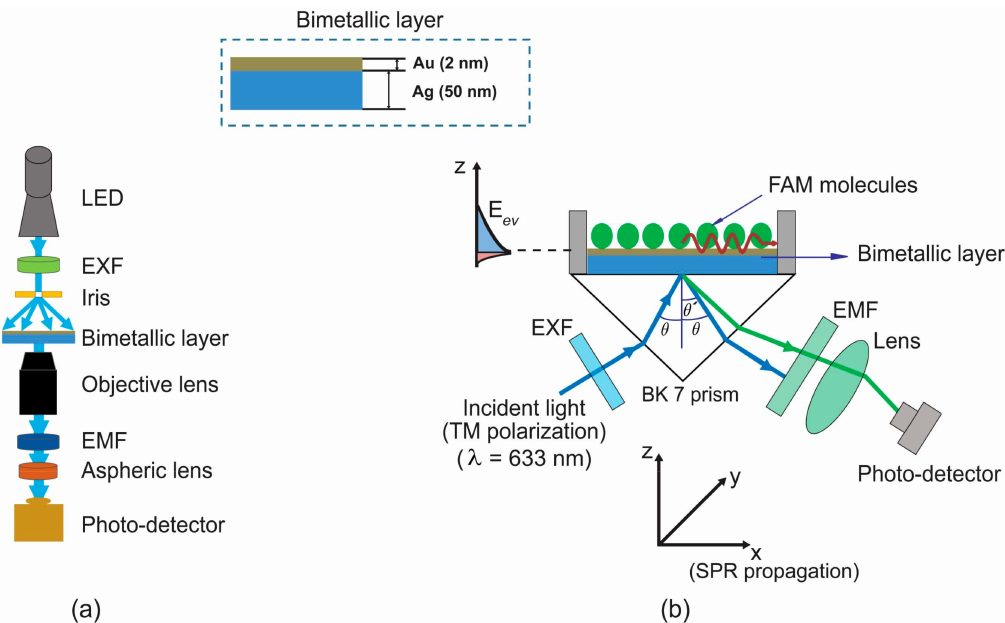
Figure 1. ( a ) A transmission geometry-based setup (T-mode) and ( b ) a prism-based set up (R-mode), for fluorescence enhancement detection. LED denotes a light emitting diode, EXF denotes an excitation filter, and EMF denotes an emission